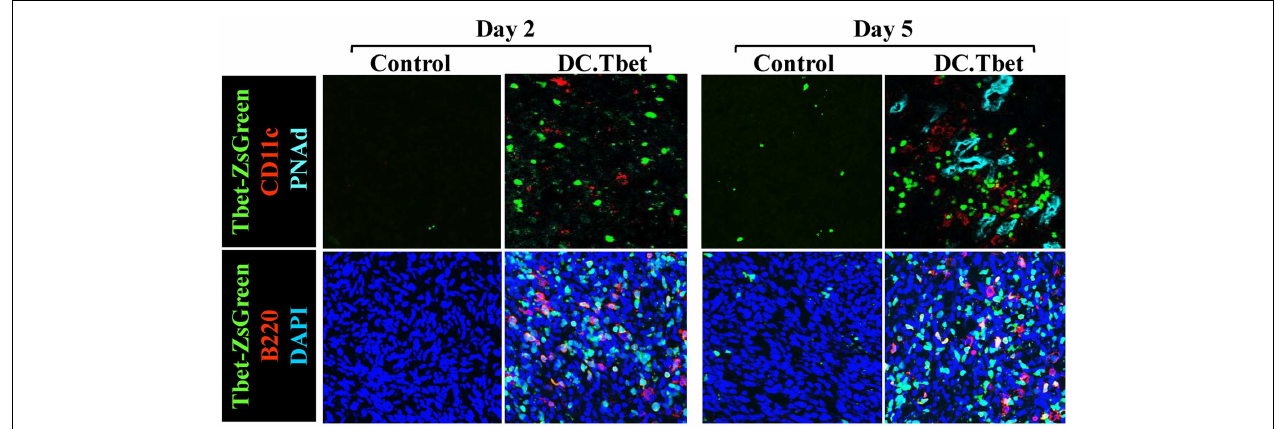
fluorescence microscopy for expression ofTbet-ZsGreen protein, CD11c (a marker of DC), B220 (a B cell marker), and PNAd (i.e., Peripheral lymph Node Addressin; a high endothelial venule (HEV) cell marker). PNAd + HEV were not observed by 2days post-treatment, but became prevalent by 5days post-injection of DC.Tbet cells. B,T, and NK cell infiltrates into DC.Tbet [Figure 1 and (5)] exhibited a diffuse distribution pattern in day 2 and day 5 DC.Tbet-treated tumors.Type-1 polarity in infiltrating cells is denoted by nuclear expression ofTbet-ZsGreen. Data are representative of images obtained in three independent experiments